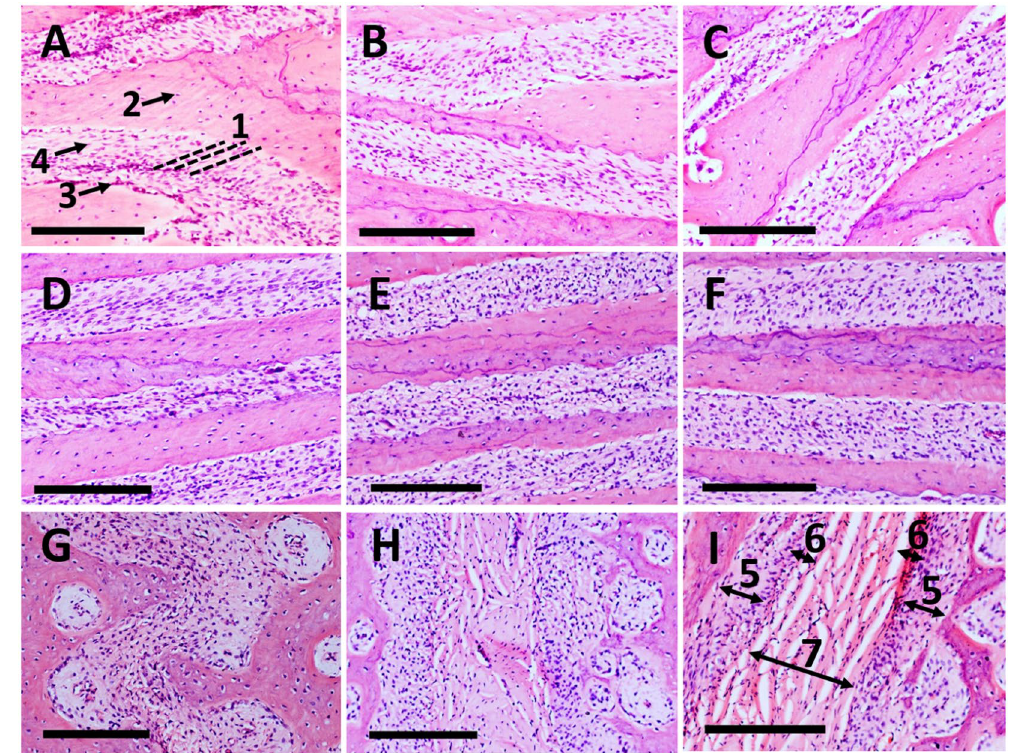
Figure 2. Histological images of the midpalatal suture (haematoxylin-eosin, 10 × , bar = 200 μ m) in the coronal plane (rostro-caudal view) from caudal ( A ) to rostral ( I ), following alphabetical order. In the most posterior region ( A ), the image shows an oblique arrangement of many ligament fibres connecting the opposing bony fronts (1); osteocytes-like cells in the inner part of the cortical bone (2); osteoblasts-like cells on the surface facing the sutural interface (3); and fibroblasts-like cells in the ligament (4). The rostral region presents two active cambial layers (5) and capsular layers (6), with a loose layer in the middle (7). Two distinct patterns of fibre orientation are visible: a parallel disposition in the most medial part of the suture, and a more radial orientation in contact with the bone ( I